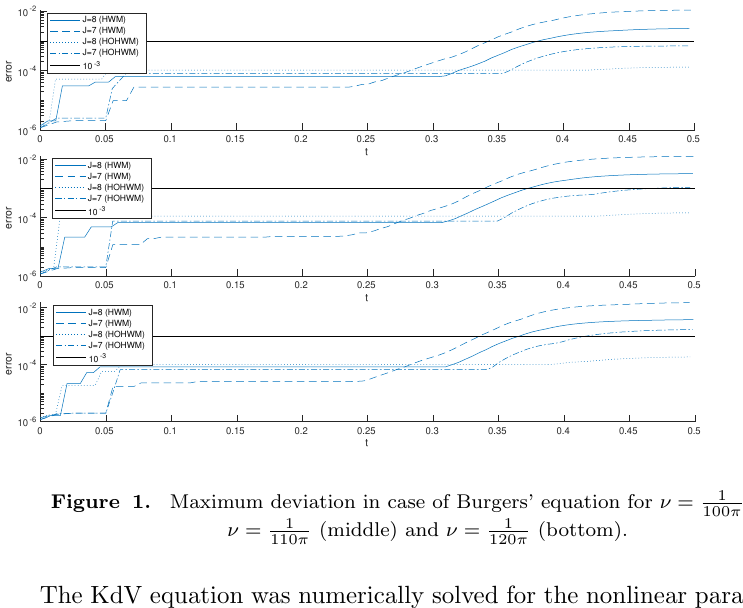
ν = 1 (middle) and ν = 1 110 π 120 π